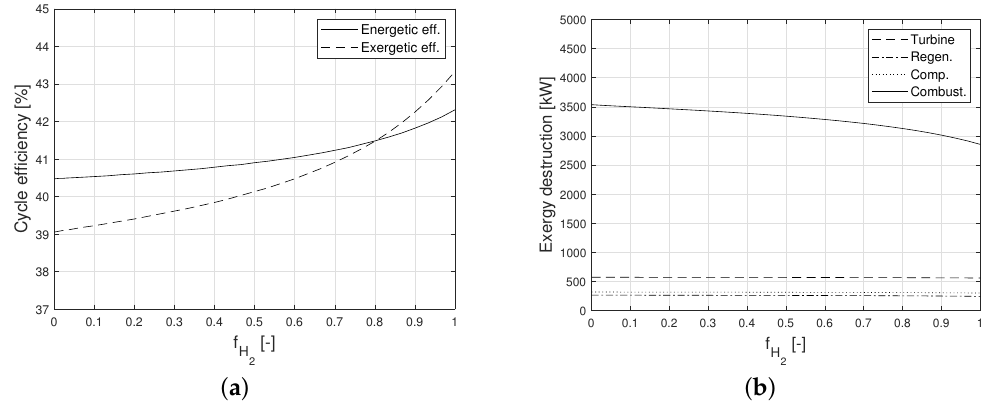
Figure 3. ( a ) Energetic and exergetic efficiencies. ( b ) Exergy destruction at each subsystem depending on the hydrogen content.